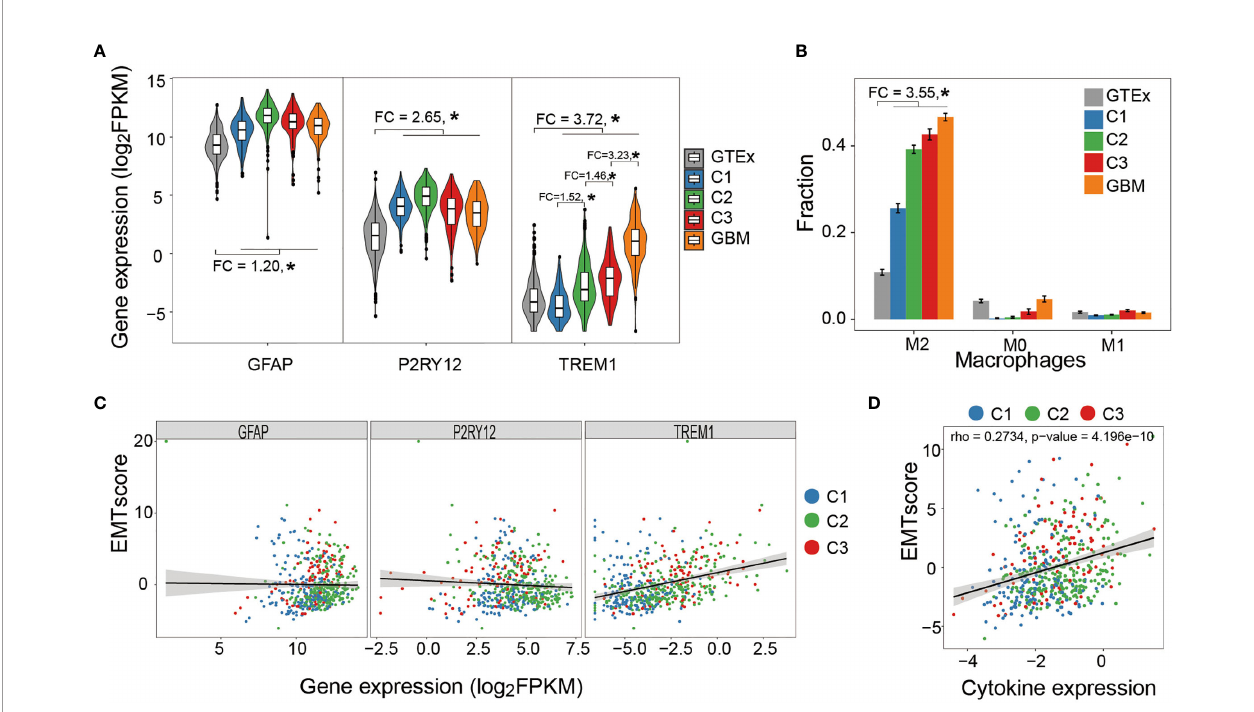
FIGURE 5 | Correlation between immune cell in fi ltration and tumor stemness. (A) Astrocyte and microglia segregate toward tumor lesion in a tumor grade- independent manner while macrophage in fi ltration positively correlated with tumor grade. (B) Relative abundance of macrophage subtypes in healthy brain tissue (GTEx), LGG subtypes, and GBM samples. Macrophage M2 was the dominant subtype and demonstrated increasing abundance from healthy tissues to tumor samples. (C) Sample-wise correlation between immune cell in fi ltration and tumor stemness showed that only macrophage in fi ltration negatively correlated with tumor stemness. (D) Sample-wise correlation between tumor stemness and average expression of cytokines that affect BBB permeability. *P <